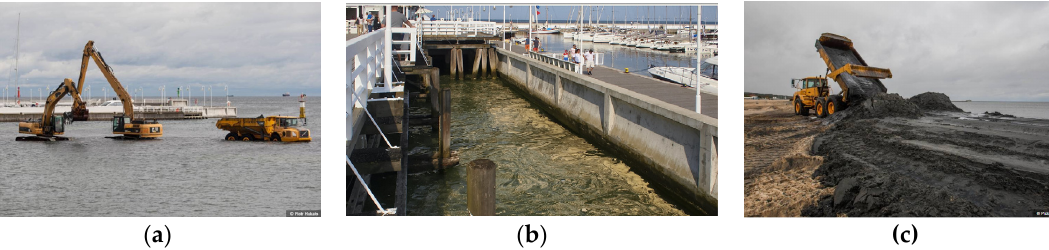
Figure 3. Removing sand from under the pier in Sopot ( a ), pine pollen and rotten sand lying around the pier ( b ), transported to the southern part of the beach in Sopot ( c ).